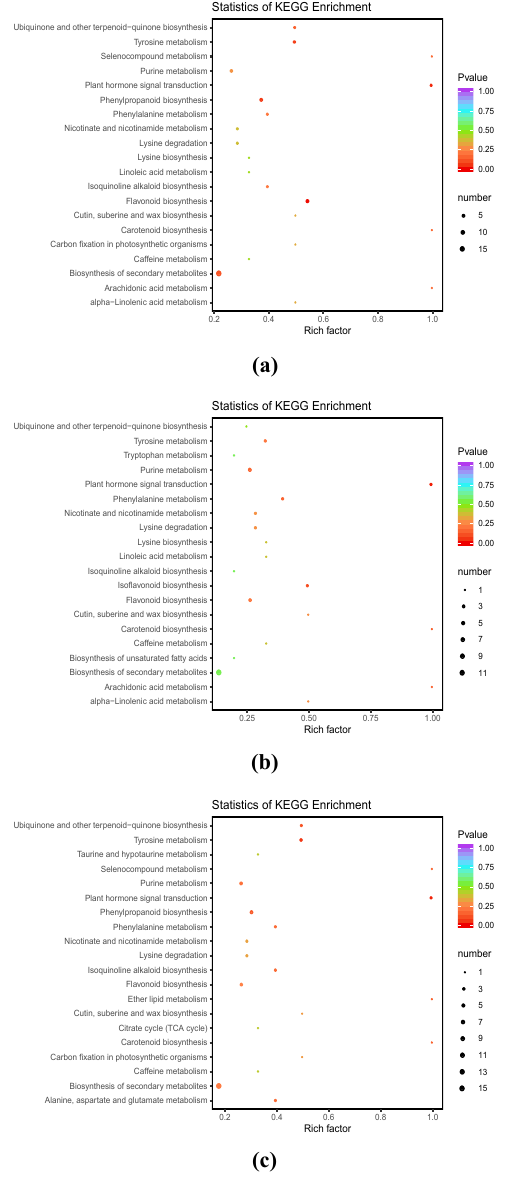
Figure 5. Kyoto Encyclopedia of Genes and Genomes (KEGG) pathway enrichment analysis of DAMs. ( a ) Pathway enrichment in WT vs. a-3. ( b ) Pathway enrichment in WT vs. a-4. ( c ) Pathway enrichment in WT vs. a-5. The abscissa represents the enrichment factor, the ordinate represents the enrichment pathway, and the dot point sizes represent the number of di ff erentially enriched